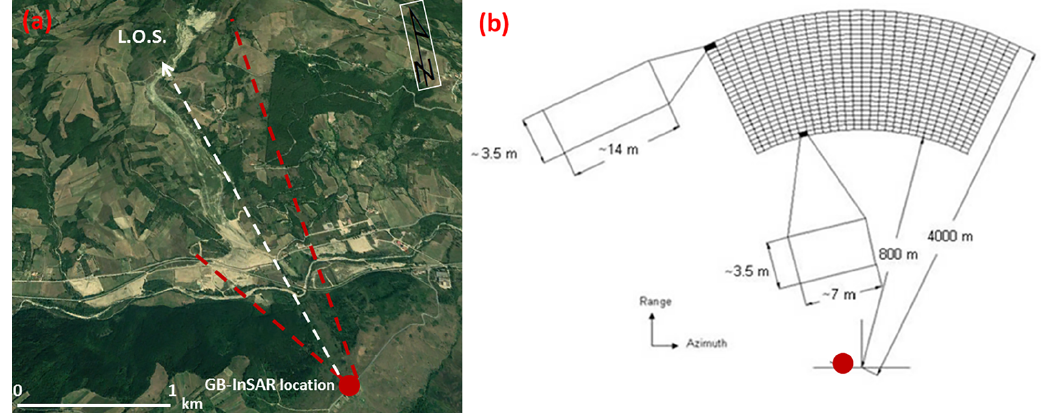
Figure 5. Location of the GB-InSAR system installation (a) and resolution grid size and parameters used during the monitoring campaign (b) .